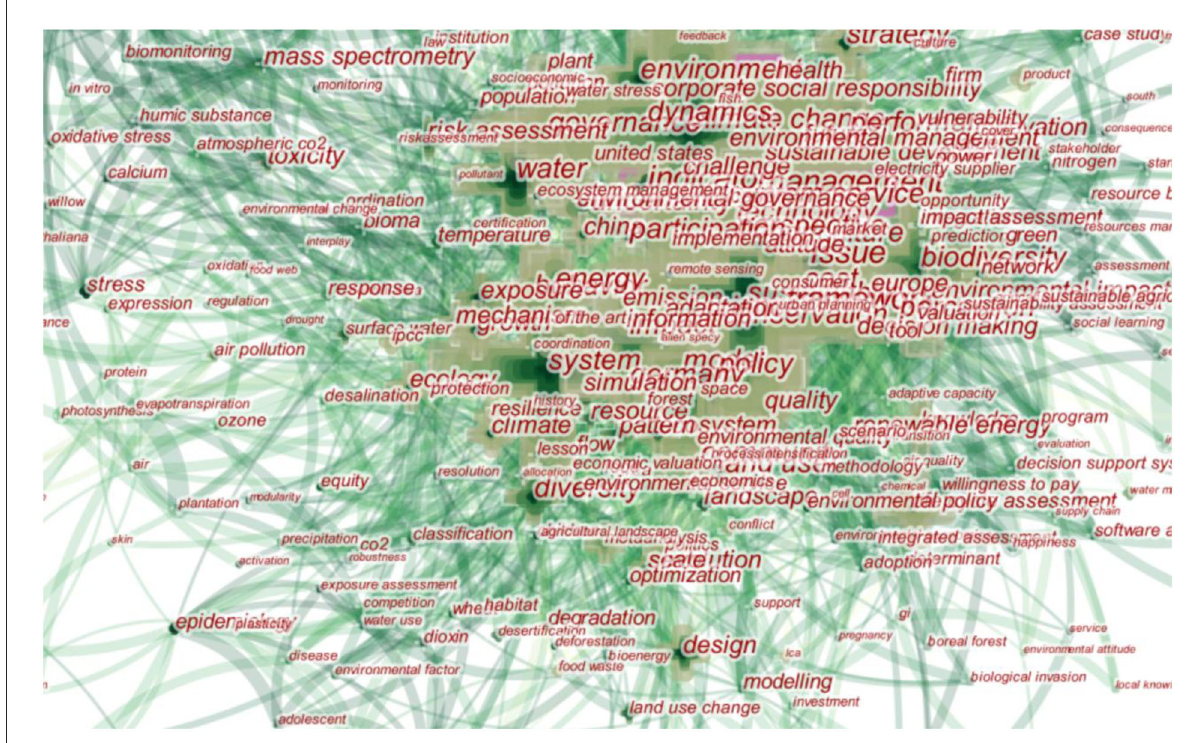
FIGURE6 Keywords of German environmental research. Source: This map was drawn by the author through